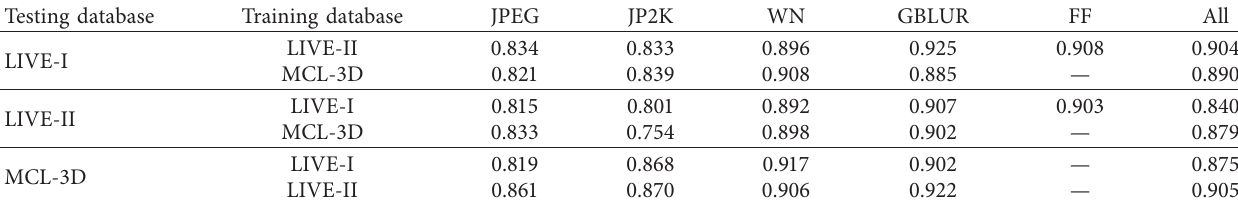
Table 6: Cross-database performance evaluation in terms of SRCC.